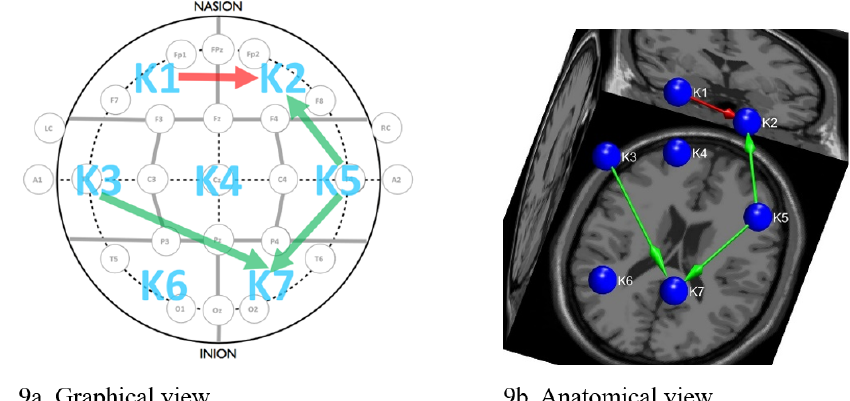
Figure 9. Estimated brain connectivity in the resolution-reaching phase for spatial intelligence tasks. Note: Arrows represent causality directions (green arrow: engineering > liberal arts; red arrow: liberal arts > engineering).